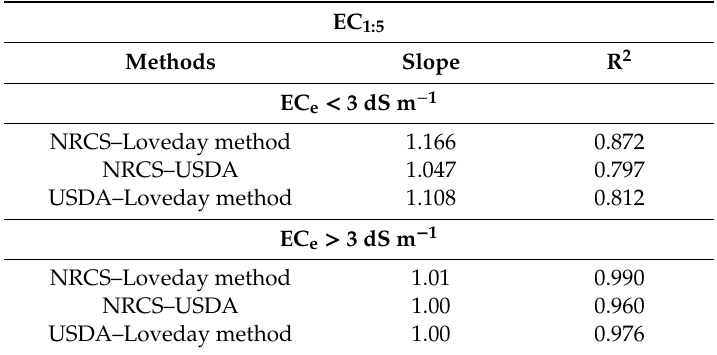
Table 2. Slopes of the linear equations describing the relation between 1:5 soil to water extract electrical